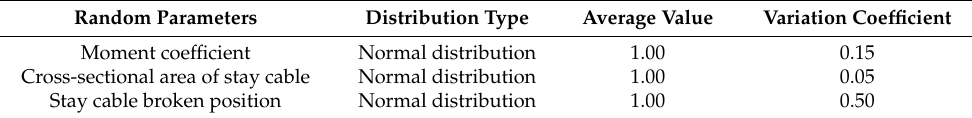
Table 4. Parameter distribution and statistical characteristic values.